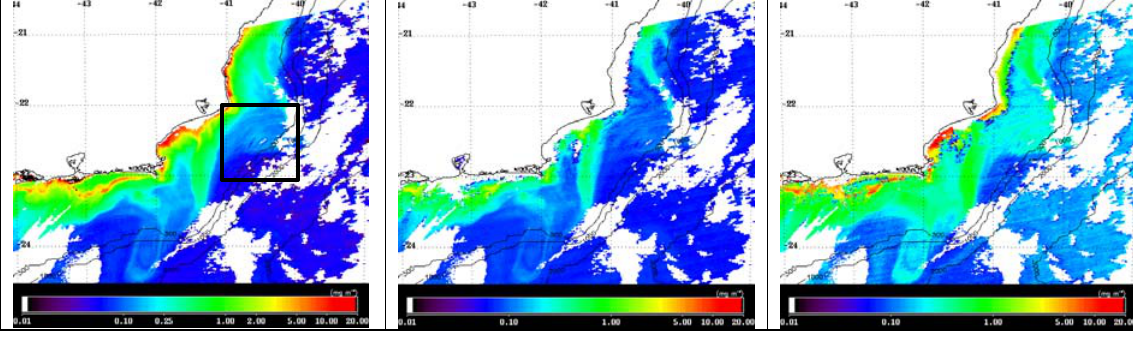
Figure 3. Surface distributions of chlorophyll concentration estimated with OC3M (left), GSM01 (center), and Carder (right) algorithms applied to MODIS data acquired on 11/25/2004 (see text for details). Isobaths in meters. Color table in logarithmic scale. Land and clouds are masked in white. Black square on the left indicates the in situ sampled